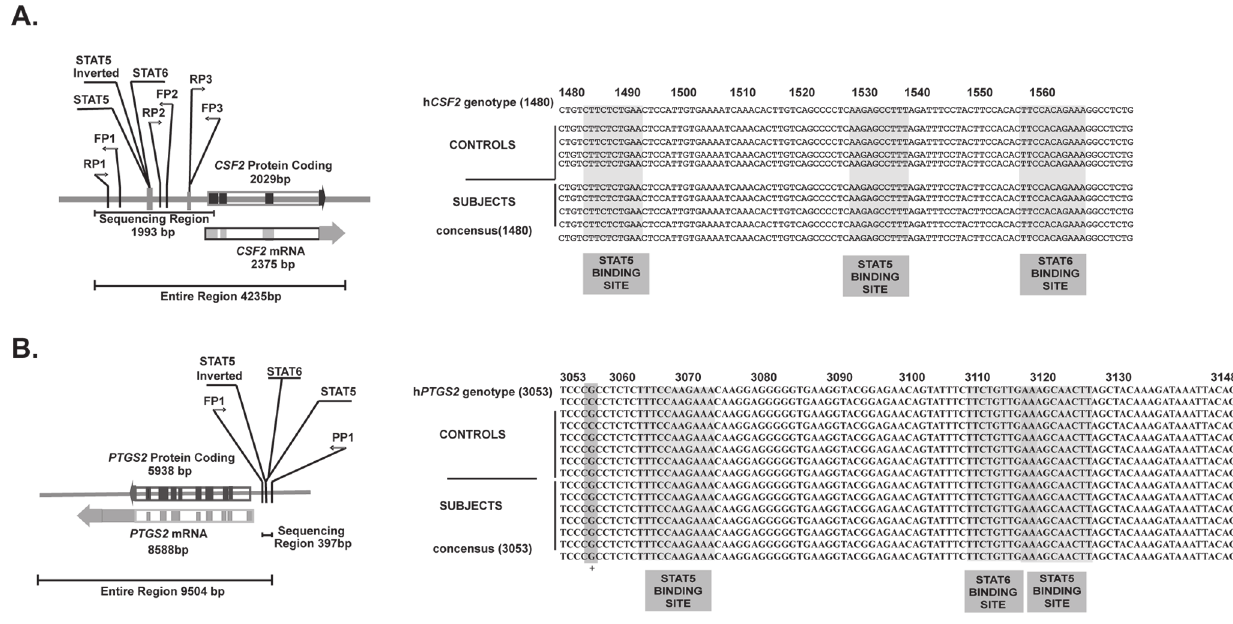
Figure 1. T1D Patient/Control Sequence Analysis for Upstream Regulatory Regions of the CSF2 and PTGS2 genes. A. Schematic representation and representative sequence data of the human promoter region upstream of CSF2, the gene encoding GM-CSF. The location of the amplified region is delineated by forward and reverse primers, FP1 and RP1, respectively. Also defined are the STAT5 and STAT6 binding sites (boxed) within the region. No T1D-specific polymorphisms have been detected in the 24 samples tested. B. Schematic representation and representative sequence data of the enhancer region upstream of the PGS2/COX2 gene, PTGS2. The location of the amplified region is delineated by forward and reverse primers, FP1 and RP1, respectively. Also defined are the STAT5 and STAT6 binding sites within the region (boxed). No T1D-specific polymorphisms have been detected in the 24 samples tested. doi:10.1371/journal.pone.0076919.g001 PLOS ONE |